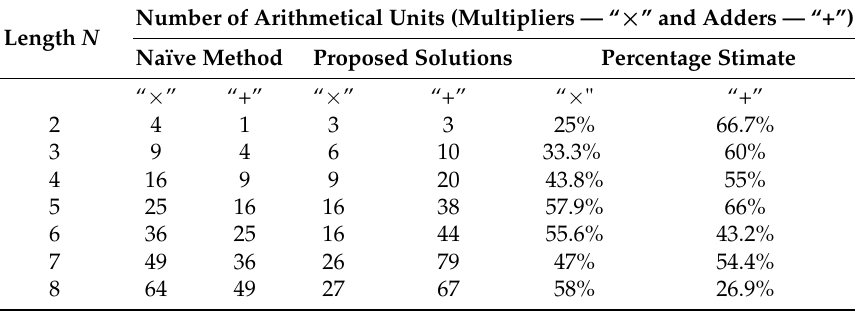
Table 1. Implementation complexities of naïve method and proposed solutions. Number of Arithmetical Units (Multipliers — “ × ” and Adders — “+”) Length N Naïve Method Proposed Solutions Percentage